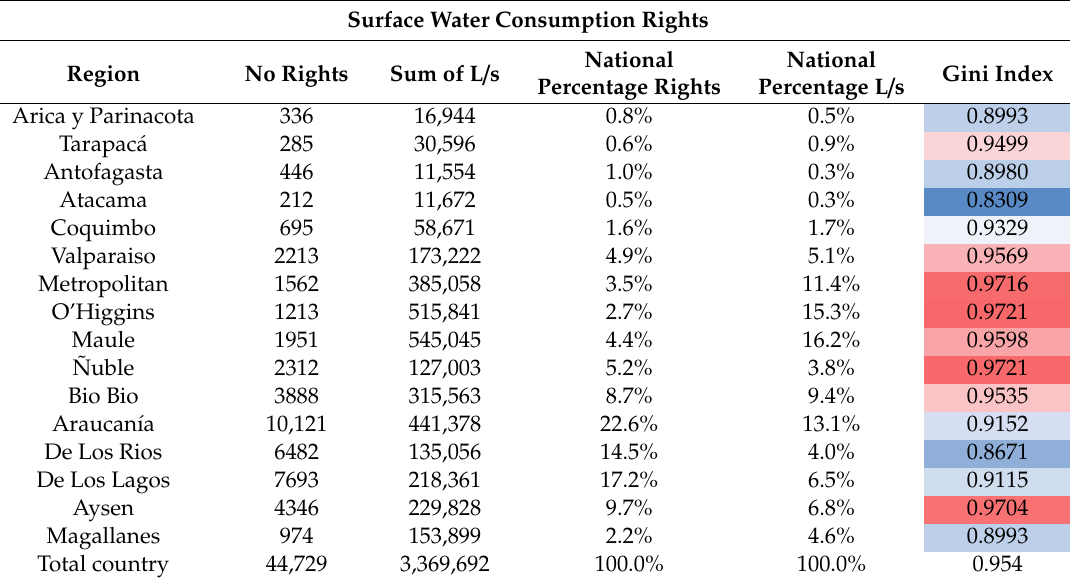
Table 5. Summary of Gini Coe ffi cient results by national regions. Source: Prepared by the